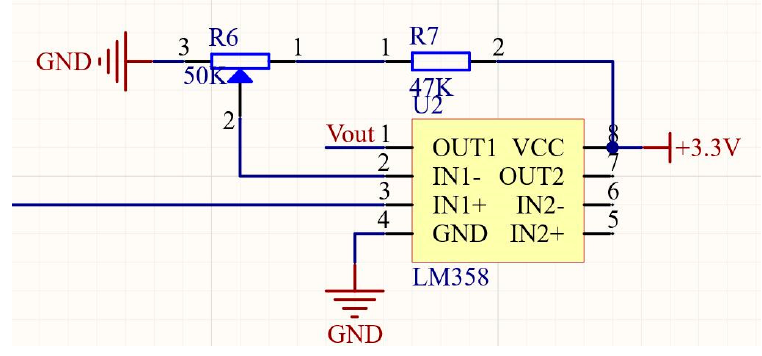
Figure 11. Voltage comparator.